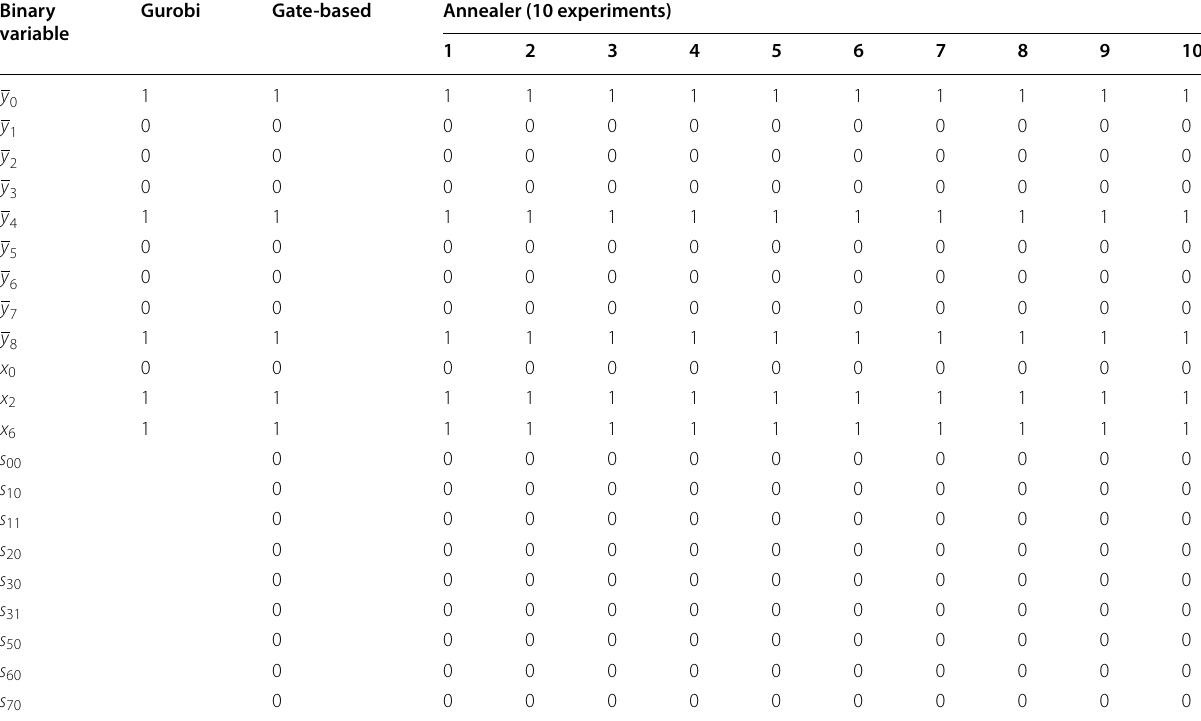
Table 3 Solution vectors of the MCLP instance presented in Fig. 2 ( p = 2 ) Binary